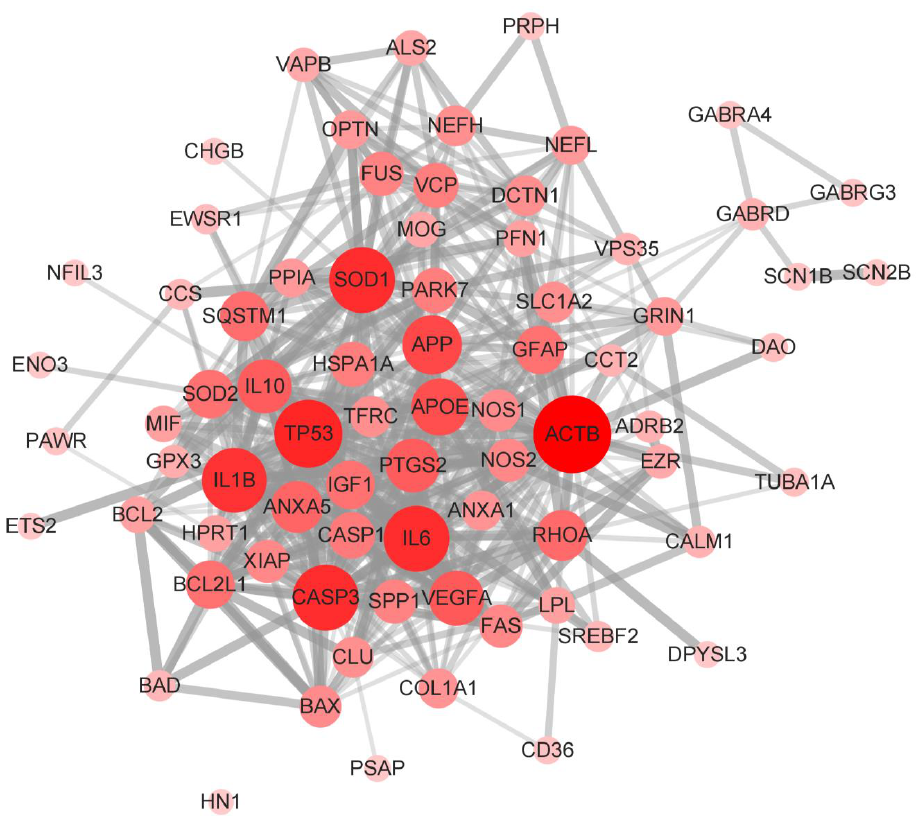
Figure 5. The molecular interaction network (PPI network) of IPA-identified SOD1-ALS pathway molecules. The PPI network was constructed using STRING and analyzed with Cytoscape. The Cytoscape network analysis predicted ACTB followed by TP53, IL6, CASP3, SOD1, IL1B, APP, APOE, and VEGFA as the major network hubs. The nodes’ size and color intensity correspond to the size of the network hub.